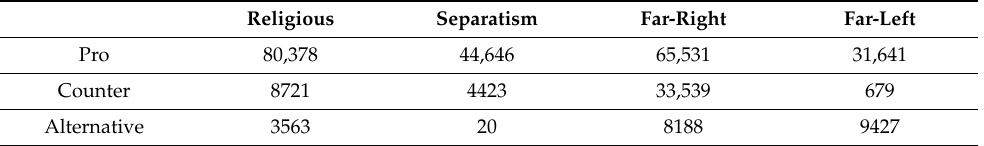
Table 3. Tweets are captured by ideology and